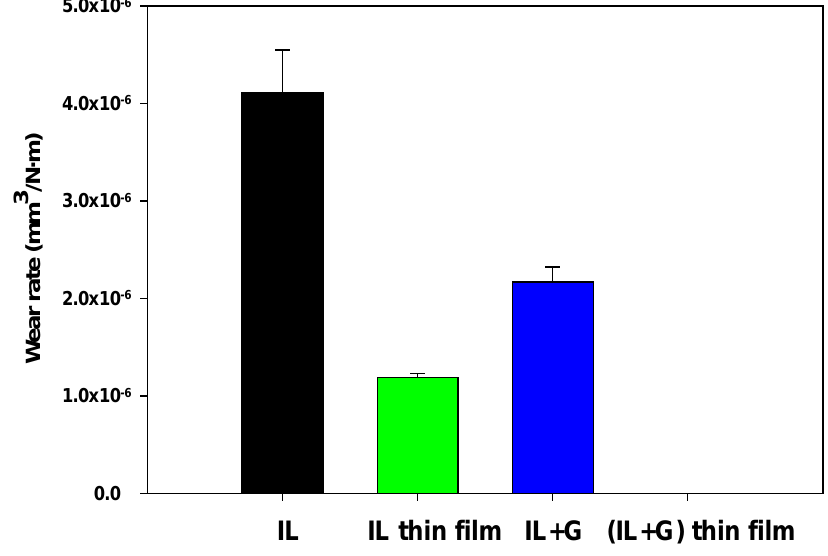
Figure 4. Wear rates of AISI 316L disks.